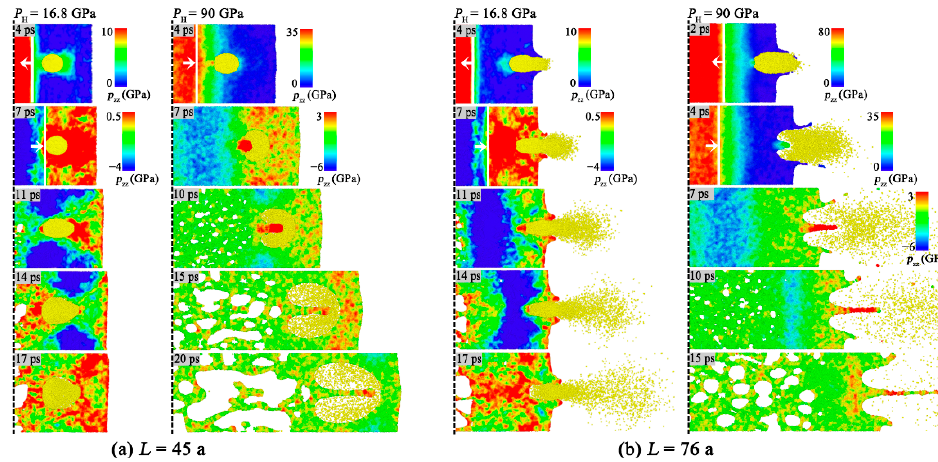
Figure 13. The stress distribution for the Al–He samples with two different configurations: ( a ) L = 45 a and ( b ) 76 a. To clearly distinguish the stress state at the matrix–bubble interface, only the Al atoms are colored. Here, the right half of model is selected.